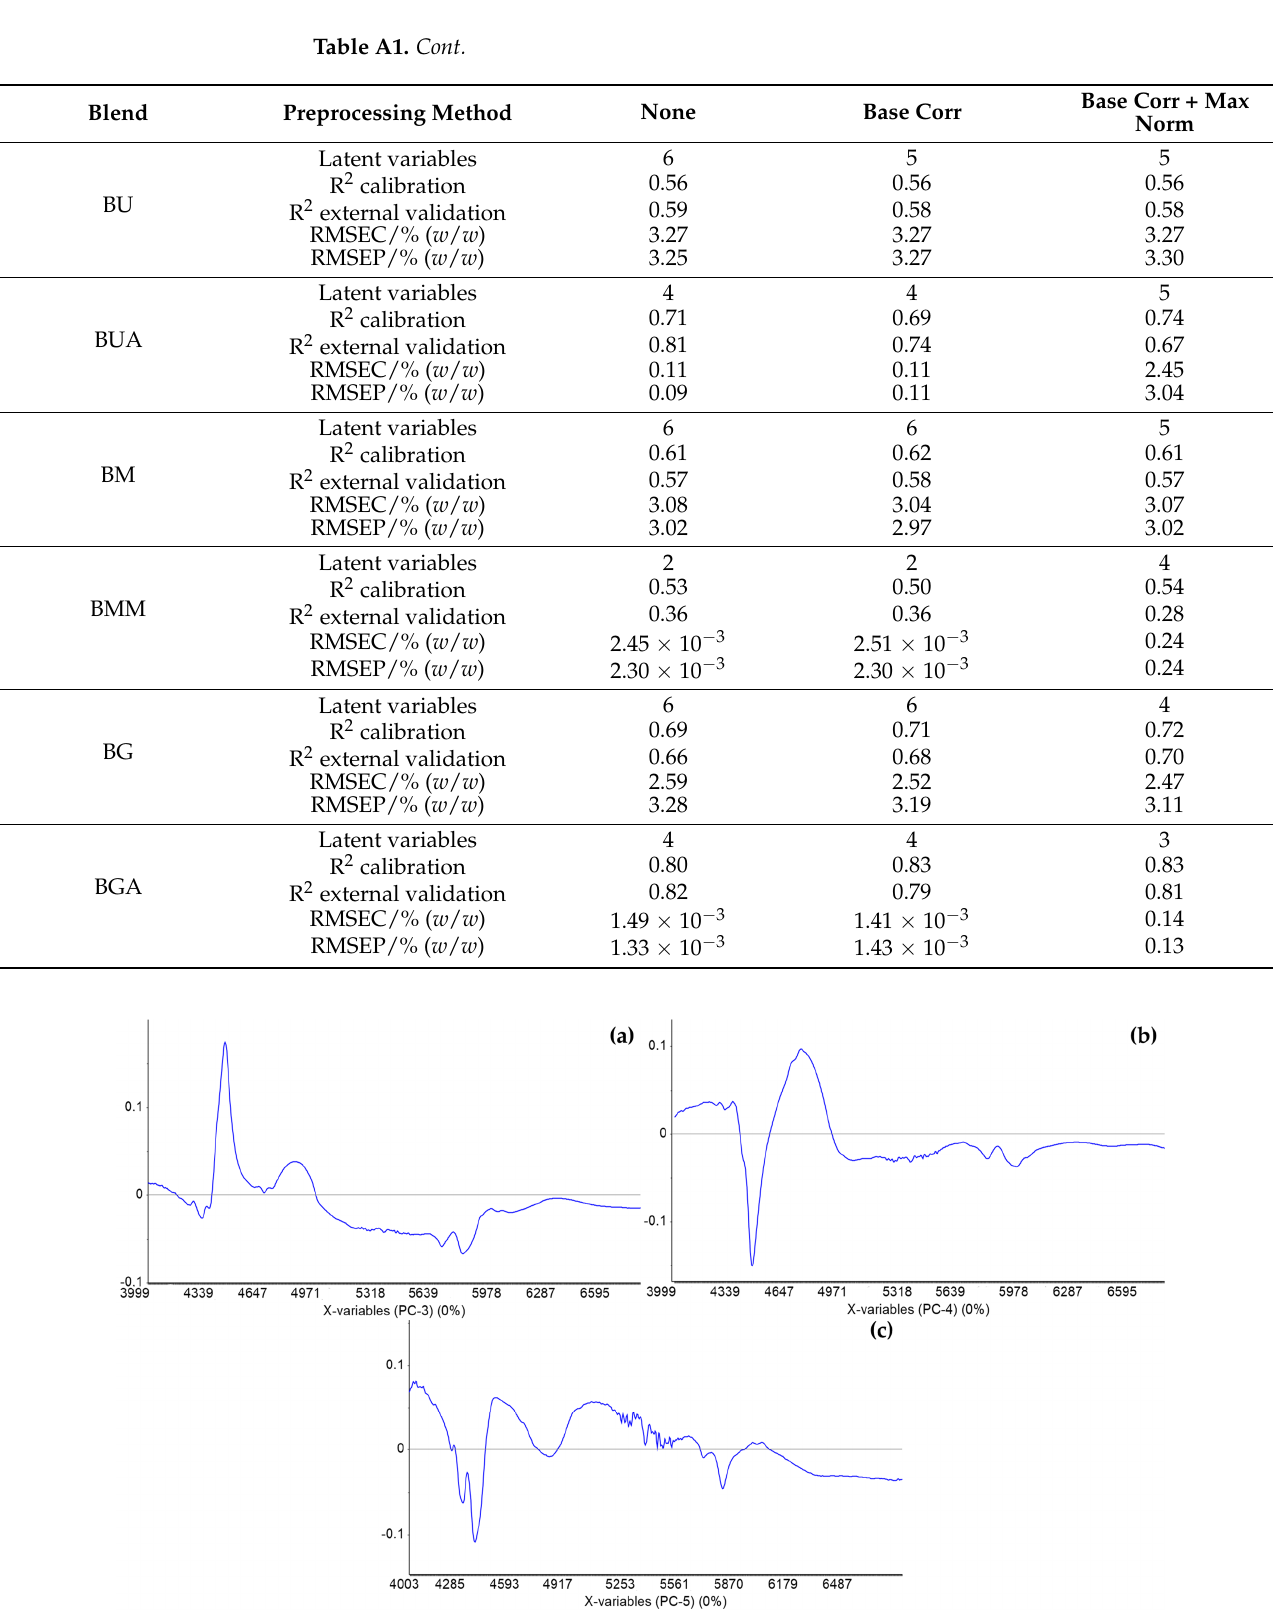
Figure A2. Loadings of ( a ) PC3, ( b ) PC4, and ( c ) PC5 of FT-NIR spectra PCA of the BX blends based on area normalization between 4000 and 6800 cm − 1 .